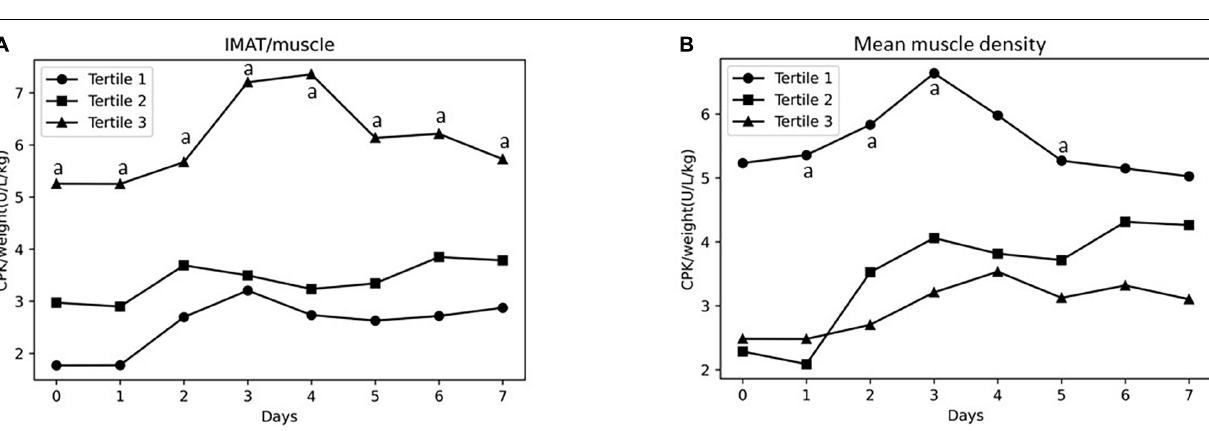
FIGURE 2 | Changes during the first 7 days from admission in ICU in CPK adjusted for weight level across IMAT/muscle tertiles (A) and mean muscle density tertiles (B) . a p <